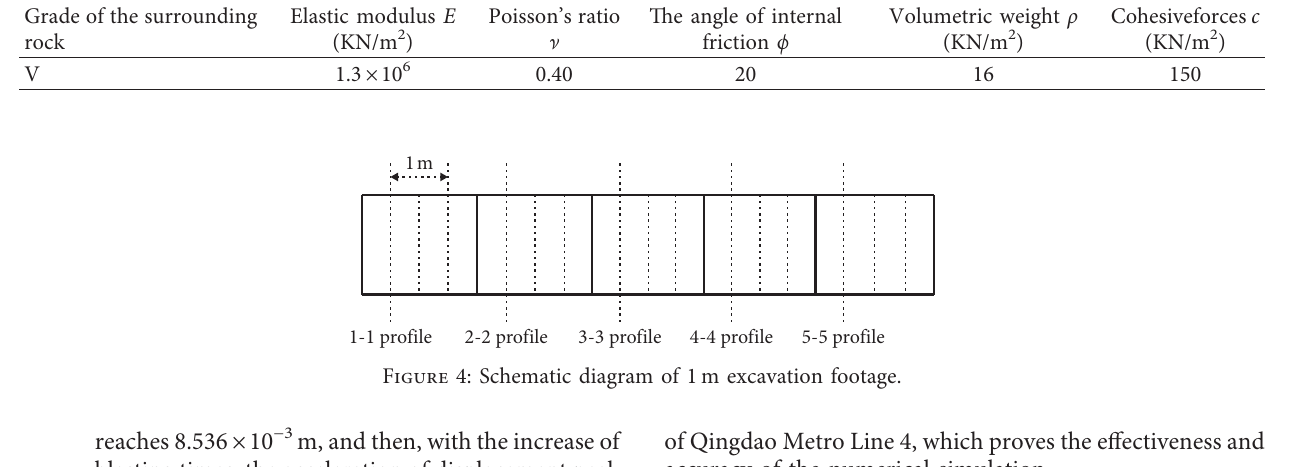
Figure 3: 3D model diagram. (a) 3D model of the surrounding rock and tunnel. (b) 1m excavation footage. Table 1: Physical and mechanical parameters of the surrounding rock.